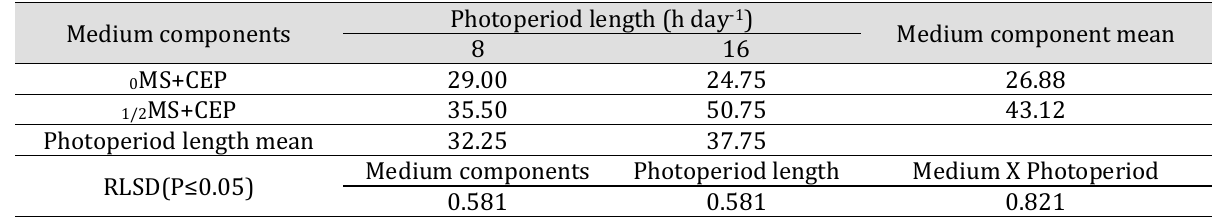
Table 2. Effect of MS salts presence and CEP of algae grown under two different photoperiods on the number of direct shoots per explant of date palm ‘Barhee’ cultivar after eight weeks of